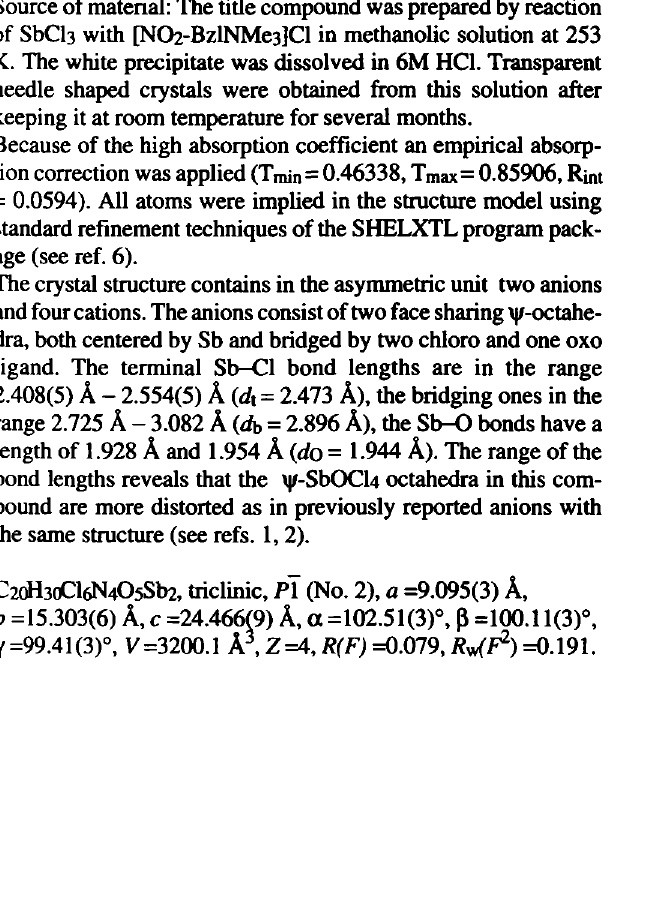
Table 2. Final atomic coordinates and displacement parameters (in